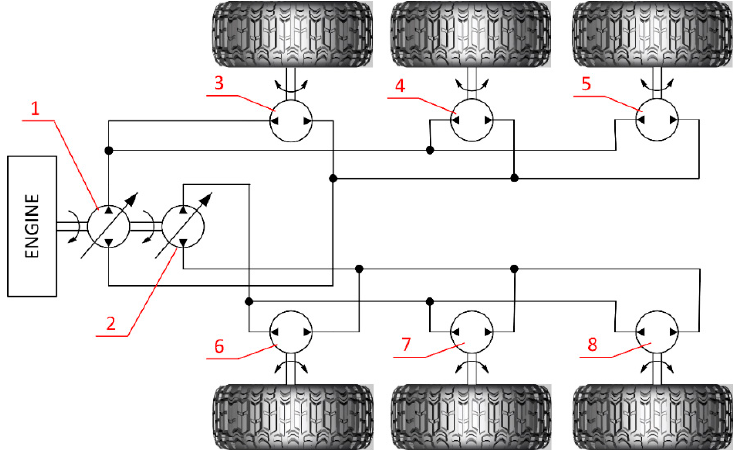
Figure 2. Main elements of the 6 × 6 robot hydrostatic drivetrain: 1, 2—variable displacement pumps; 3, 4, 5—robot left side hydraulic motors; 6, 7, 8—robot right side hydraulic motors.